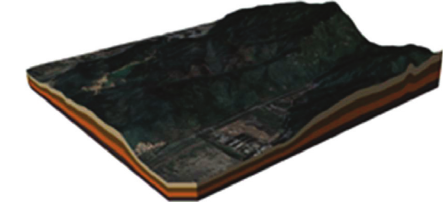
Figure 2: Topographic overview.